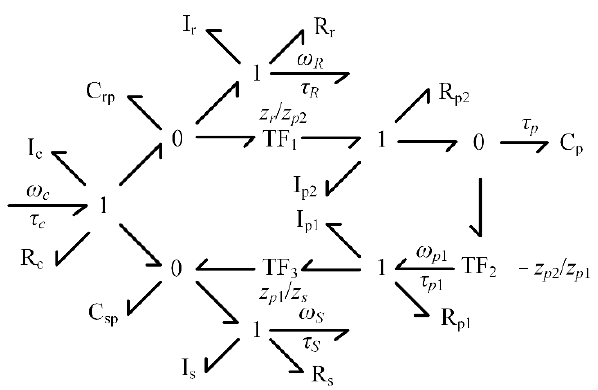
Figure 5. BG model of the D-PGT.